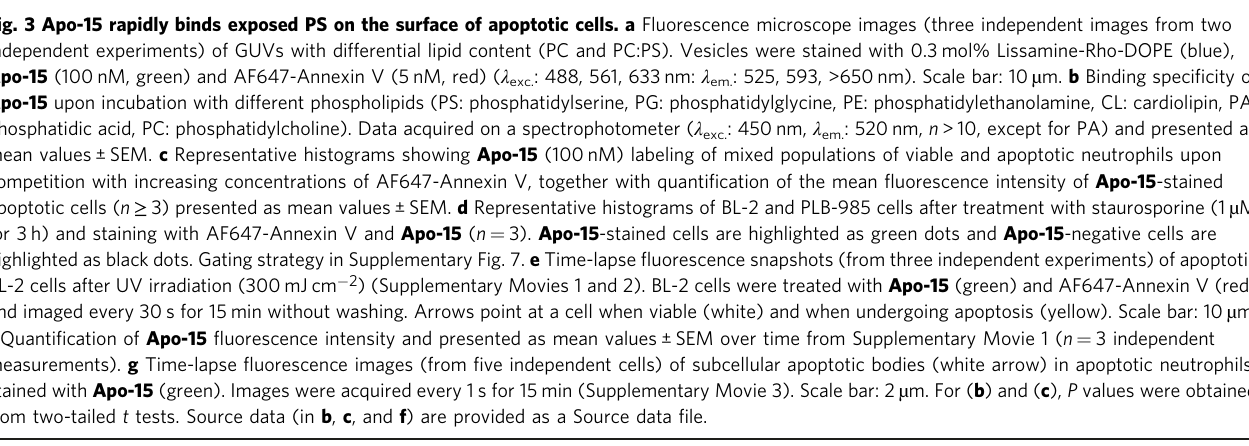
Fig. 3 Apo-15 rapidly binds exposed PS on the surface of apoptotic cells. a Fluorescence microscope images (three independent images from two independent experiments) of GUVs with differential lipid content (PC and PC:PS). Vesicles were stained with 0.3 mol% Lissamine-Rho-DOPE (blue), Apo-15 (100 nM, green) and AF647-Annexin V (5 nM, red) ( λ exc. : 488, 561, 633 nm: λ em. : 525, 593, >650 nm). Scale bar: 10 µ m. b Binding speci fi city of Apo-15 upon incubation with different phospholipids (PS: phosphatidylserine, PG: phosphatidylglycine, PE: phosphatidylethanolamine, CL: cardiolipin, PA: mean values ± SEM. c Representative histograms showing Apo-15 (100 nM) labeling of mixed populations of viable and apoptotic neutrophils